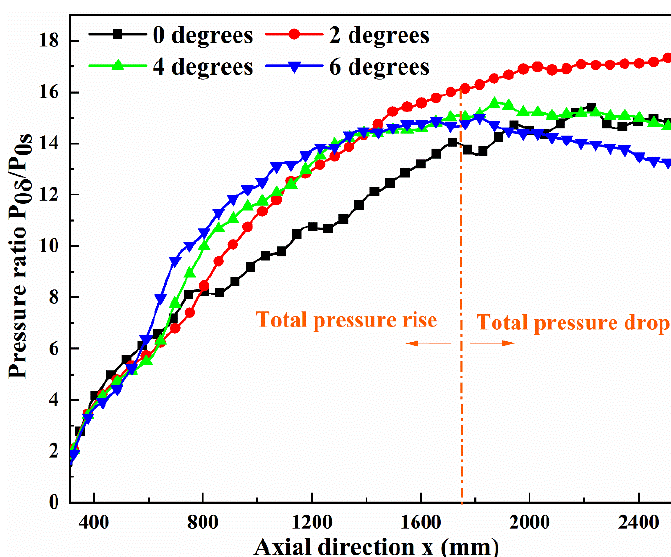
Figure 14. Variation trend of P 0 δ /P 0s with different φ .